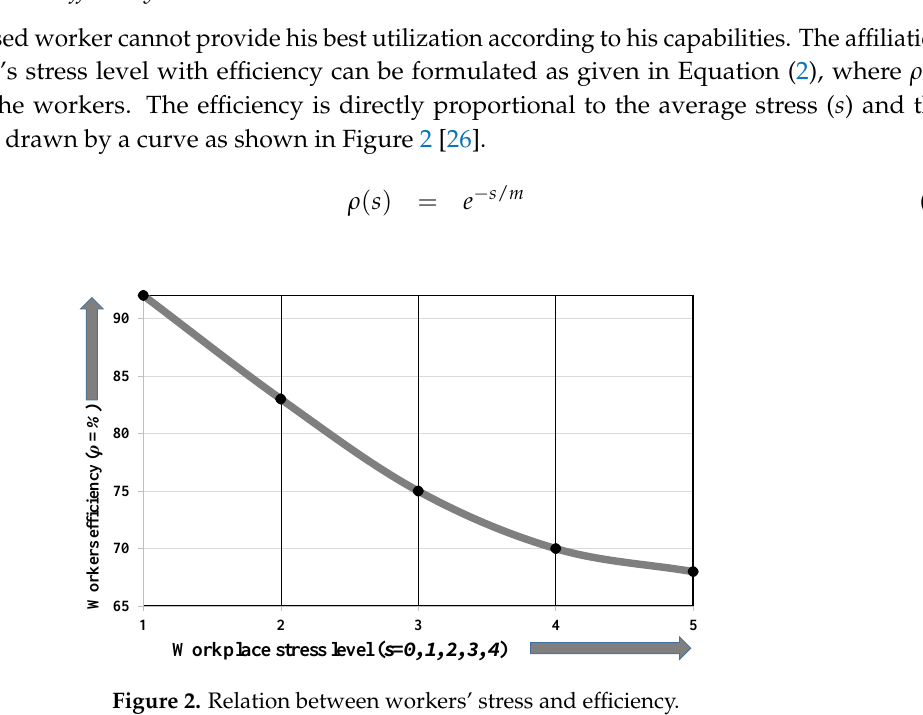
Figure 2. Relation between workers’ stress and